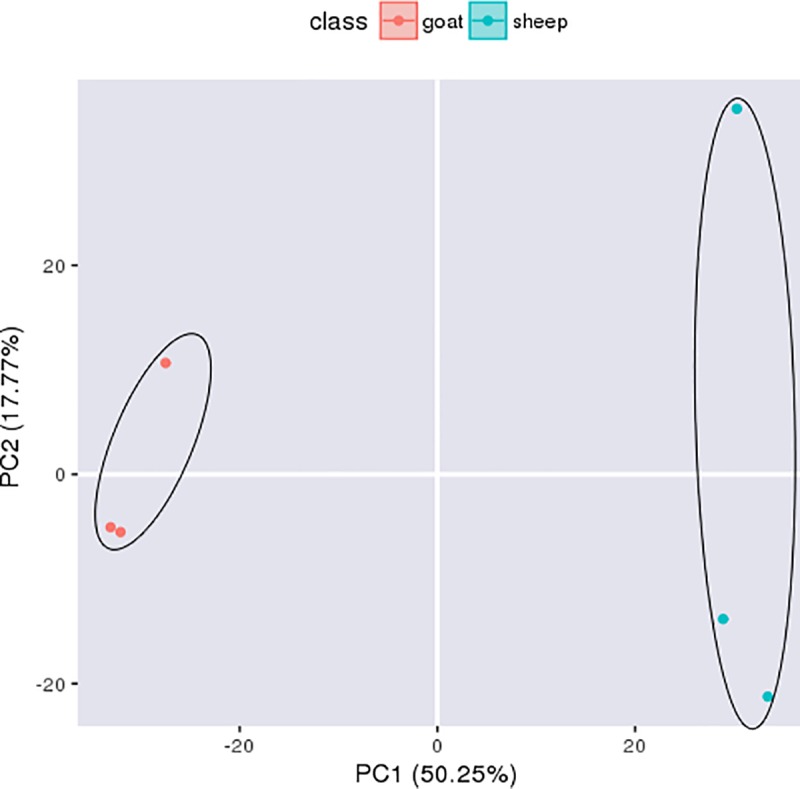
Principal component analysis (PCA) scores plot of qualified spermatozoa proteins from ram and buck.Each symbol represents one sample, and group of samples defined by PCA are enclosed in circles.